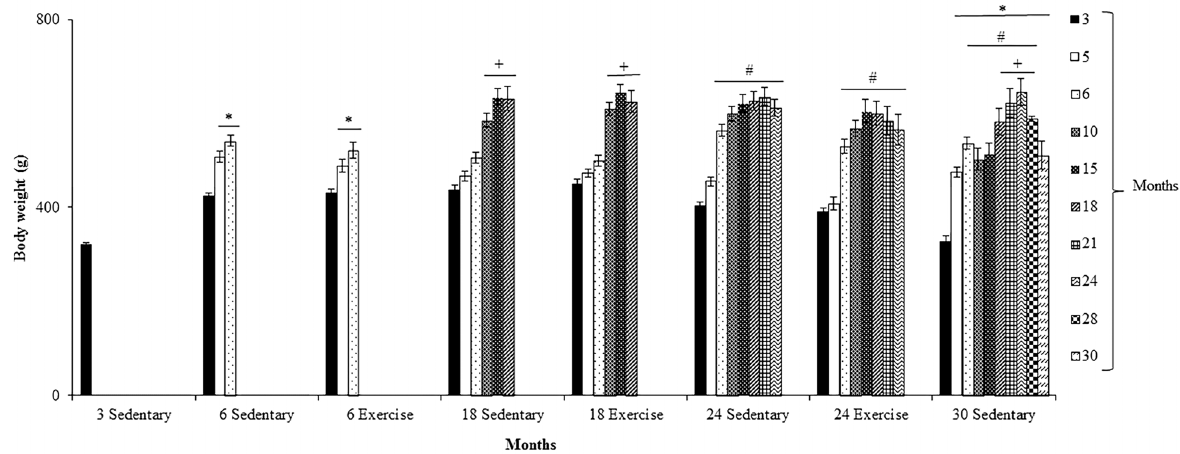
Figure 1. Body weight gain of sedentary Wistar rats 3, 6, 18, 24, and 30 months old and the effects of 12 weeks of treadmill running (Exercise) on this gain in rats 6, 18, and 24 months old. Data are reported as means ± SE. *P o 0.05 compared to 3-month-old rats;